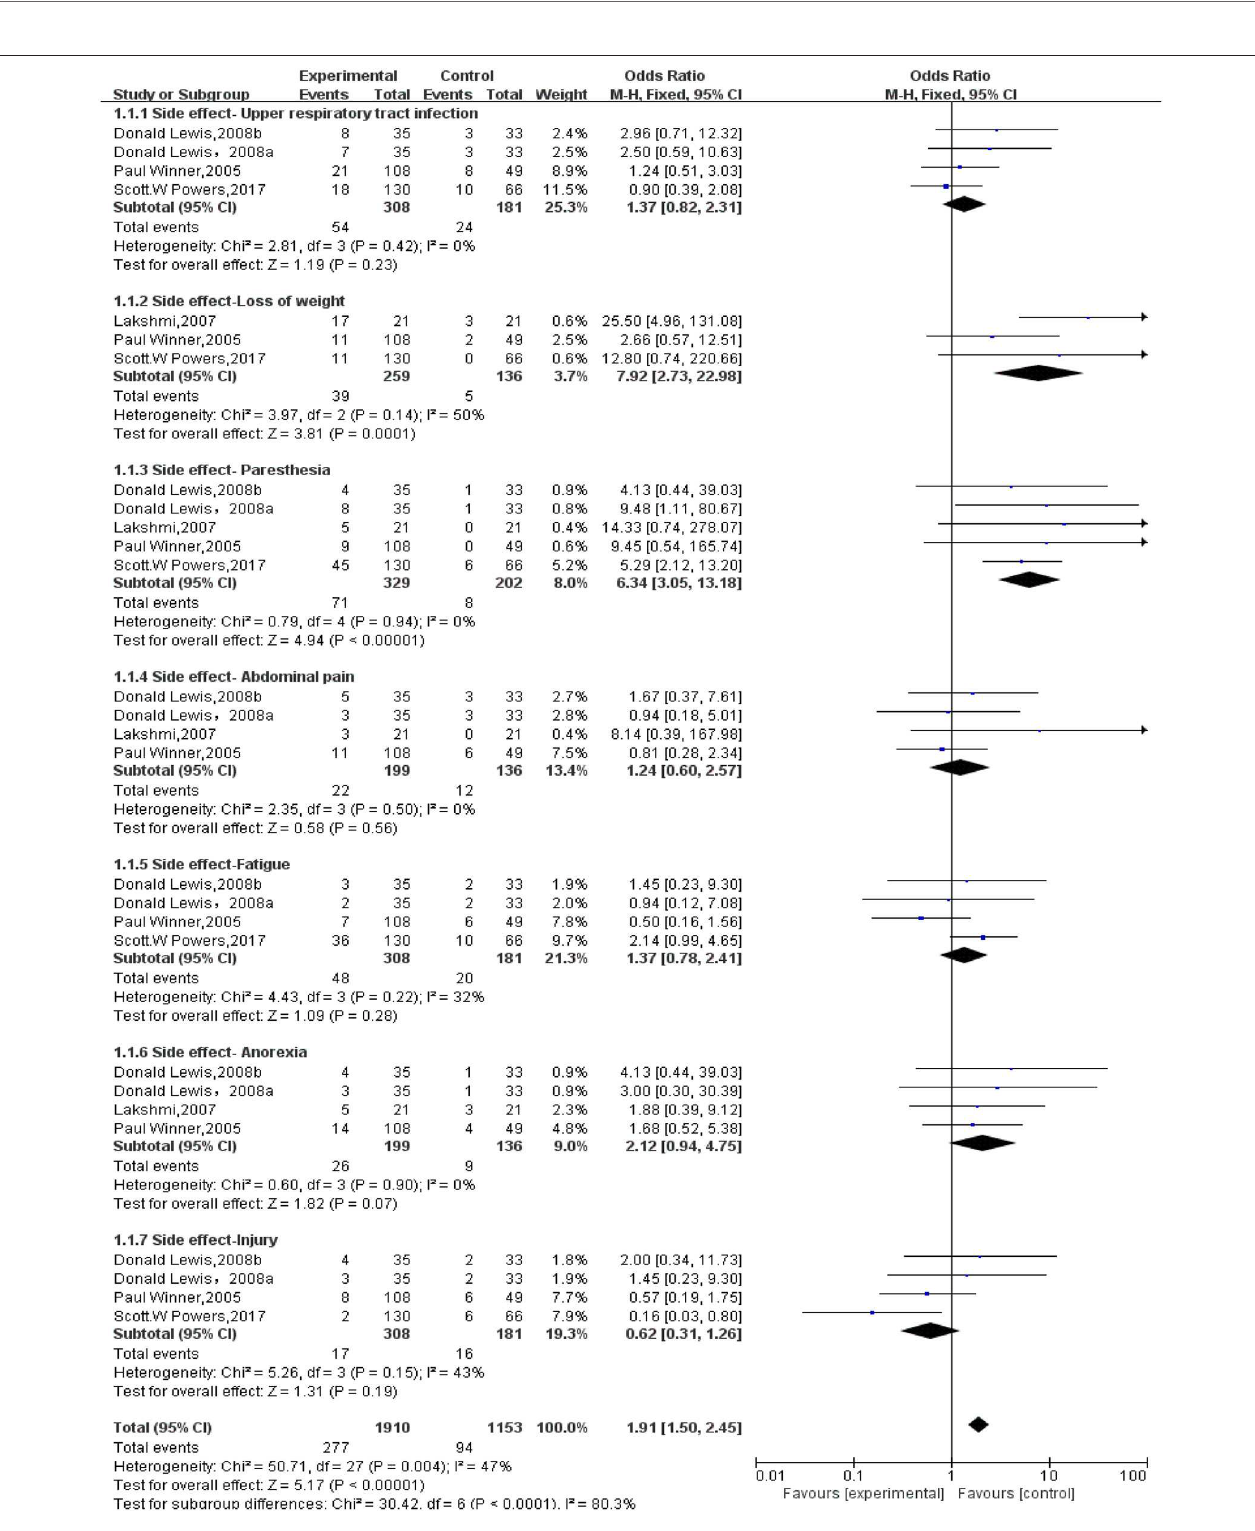
FIGURE 6 | Comparison of side effects and adverse reactions between topiramate and placebo groups. All the four included studies reported that the topiramate group was associated with higher rate than the placebo group.